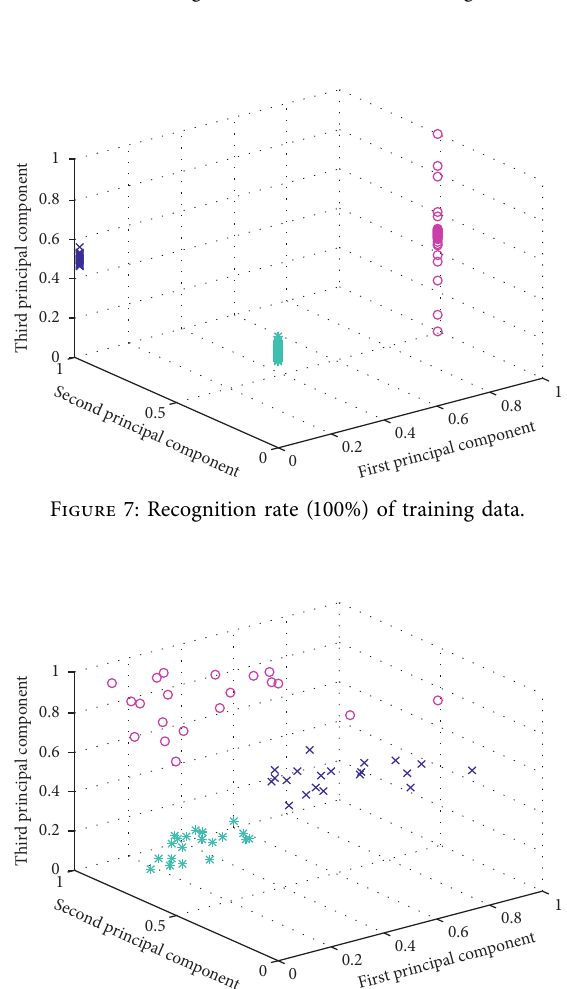
Figure 9: Recognition rate (95%) of test data.